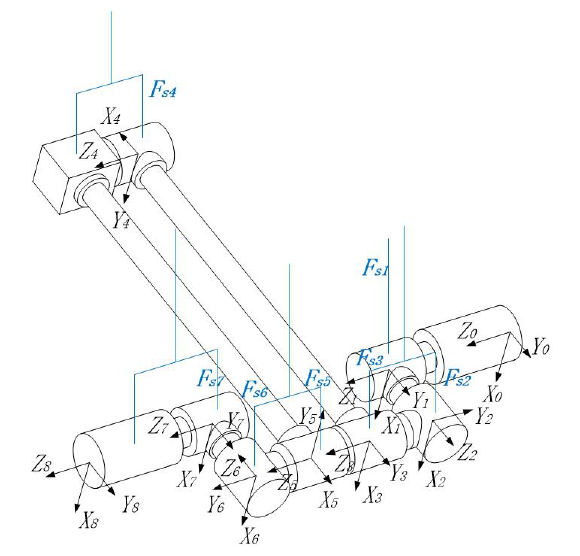
Figure 2. Manipulator and coordinate